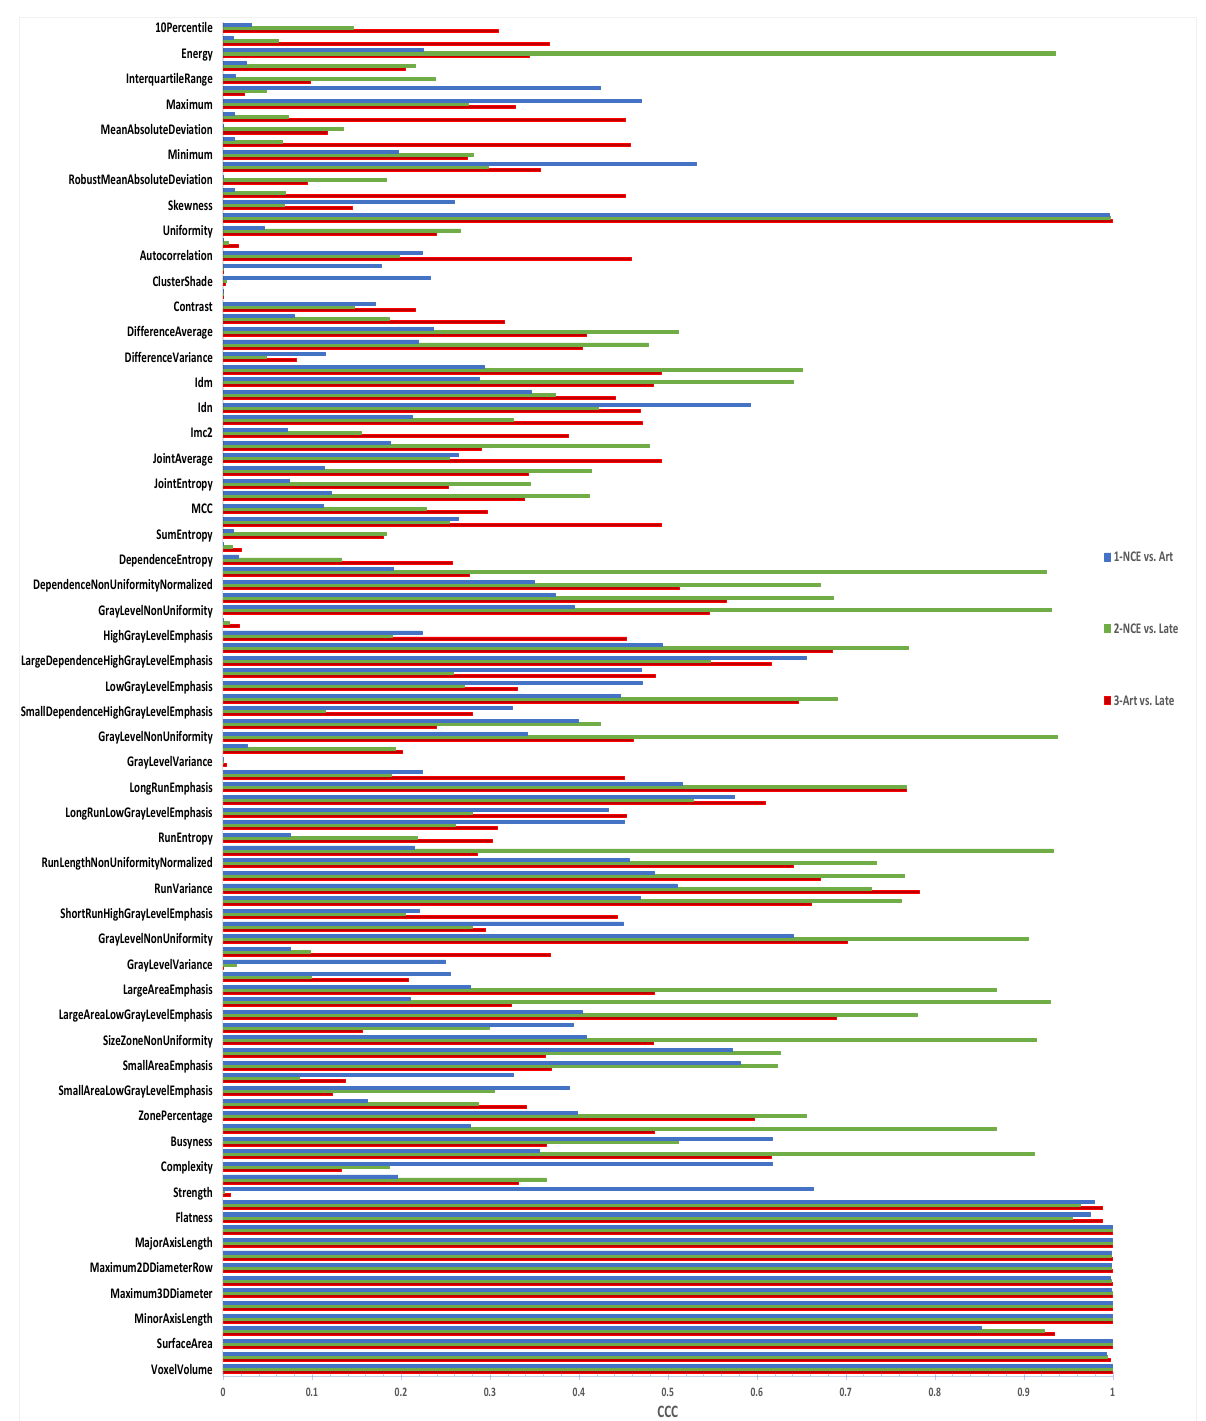
Figure 1. CCC values for RFs across the different imaging phases before harmonization. Across the non-contrast enhanced and late phase scans, 24 (22.4%) RFs were repro- ducible. In this scenario, all shape, two first order (total energy and energy), 2 GLDM (gray level non-uniformity and dependence non-uniformity), 2 GLRLM (gray level non- uniformity and run length non-uniformity), 3 GLSZM (gray level non-uniformity, size zone non-uniformity, and large area high gray level emphasis), and 1 NGTDM (Coarseness) features were found to be reproducible. The rest of the RFs had CCC values within the range of 0.0–0.87, with a median of